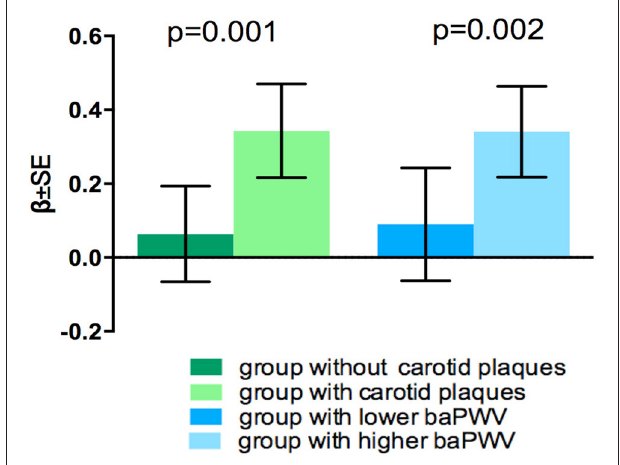
FIGURE 1 | Effect modification of carotid plaques and baPWV on association between eGFR and BPF.